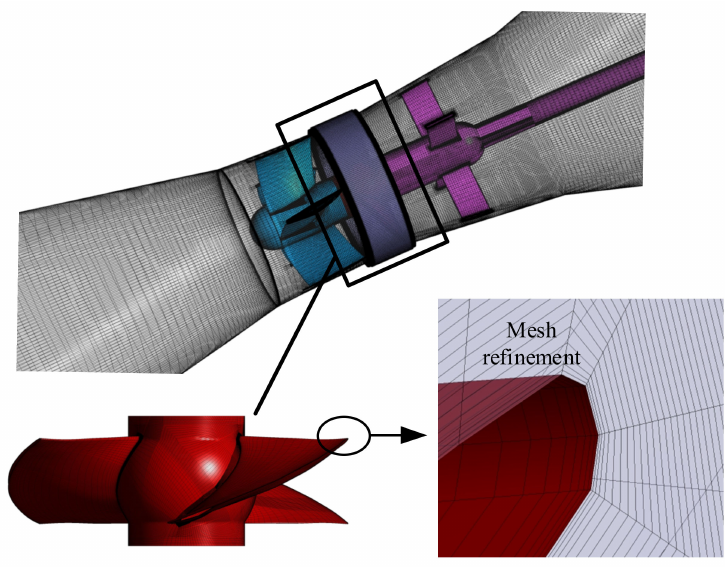
Figure 2. Mesh of full tubular pump device.